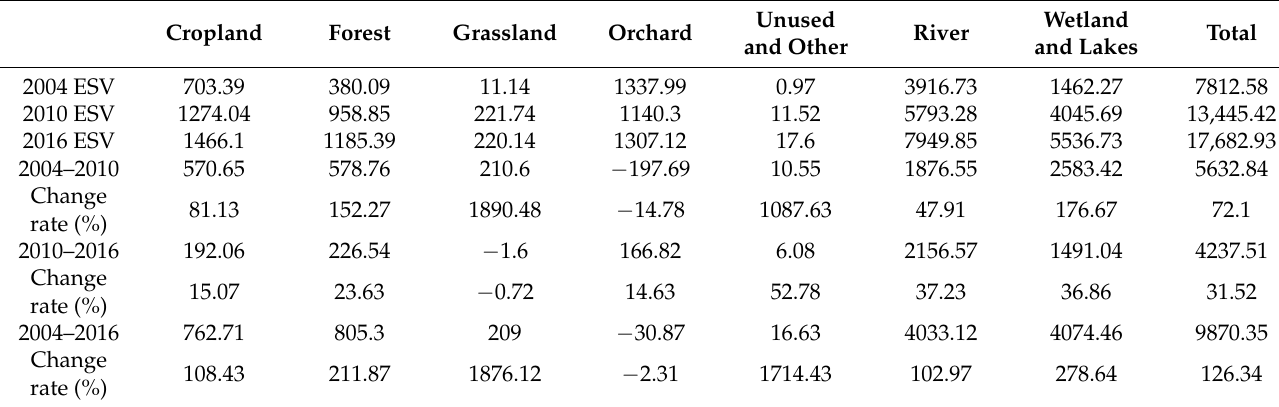
Table 8. The total ESV of each land use and its changes (million